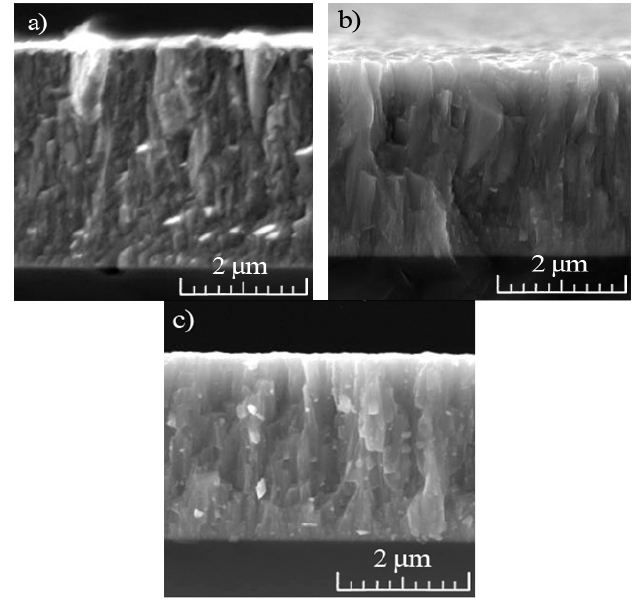
Figure 1. Cross-section SEM images of CrN x deposited at various biases: ( a ) 60 V, ( b ) 90 V, and ( c ) 120 V.